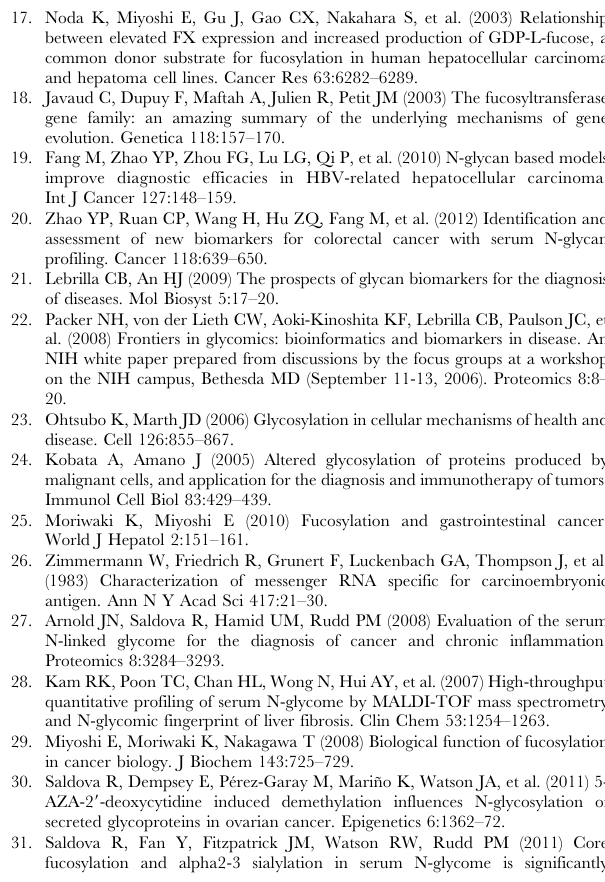
(JPG) Figure S2 The Images under microscope of transfection efficiency of gastric cancer cells. A: The image of BGC-823 cells after transfection with pEGFP-N1-GDP-Tr taken under fluoroscope light. B: The image of BGC-823 cells after transfection with pEGFP-N1-GDP-Tr taken under natural light. C: The image of SGC-7901 cells after transfection with pEGFP-N1-Fut8 taken under fluoroscope light. D: The image of SGC-7901 cells after transfection with pEGFP-N1-Fut8 taken under natural light. Table S1 PCR primer pairs used in quantitative RT-PCR. Table S2 PCR primer pairs used in Recombinant Plasmids